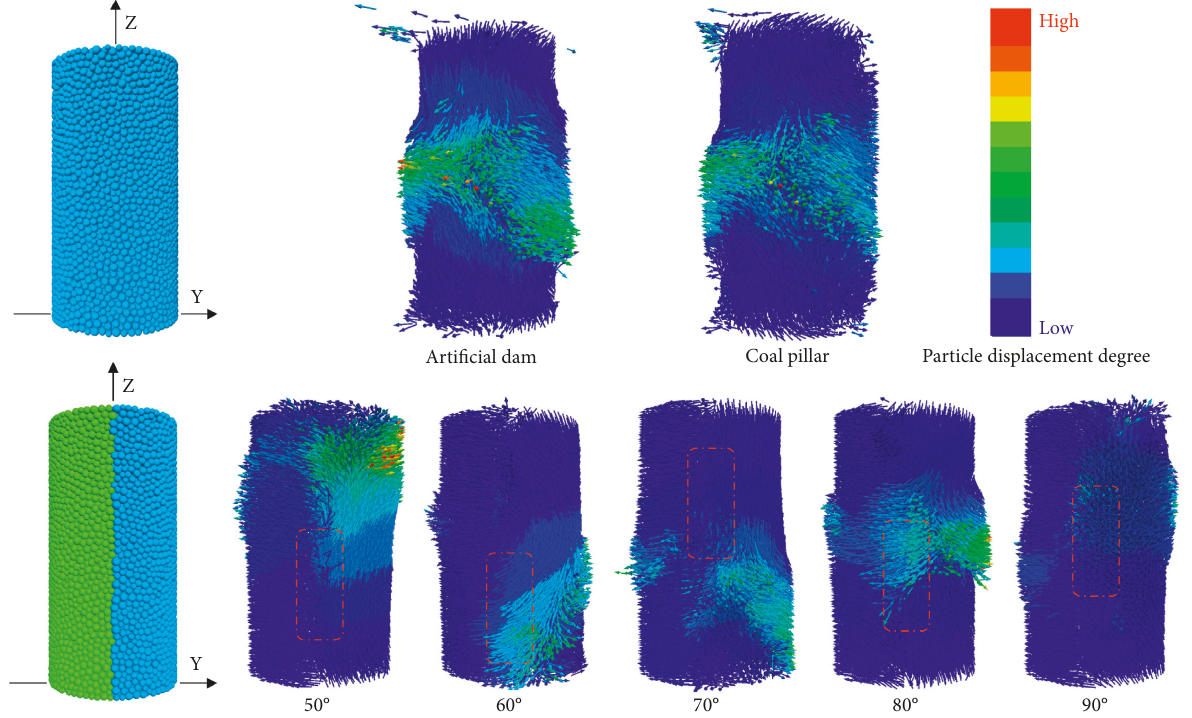
Figure 18: Particle displacement